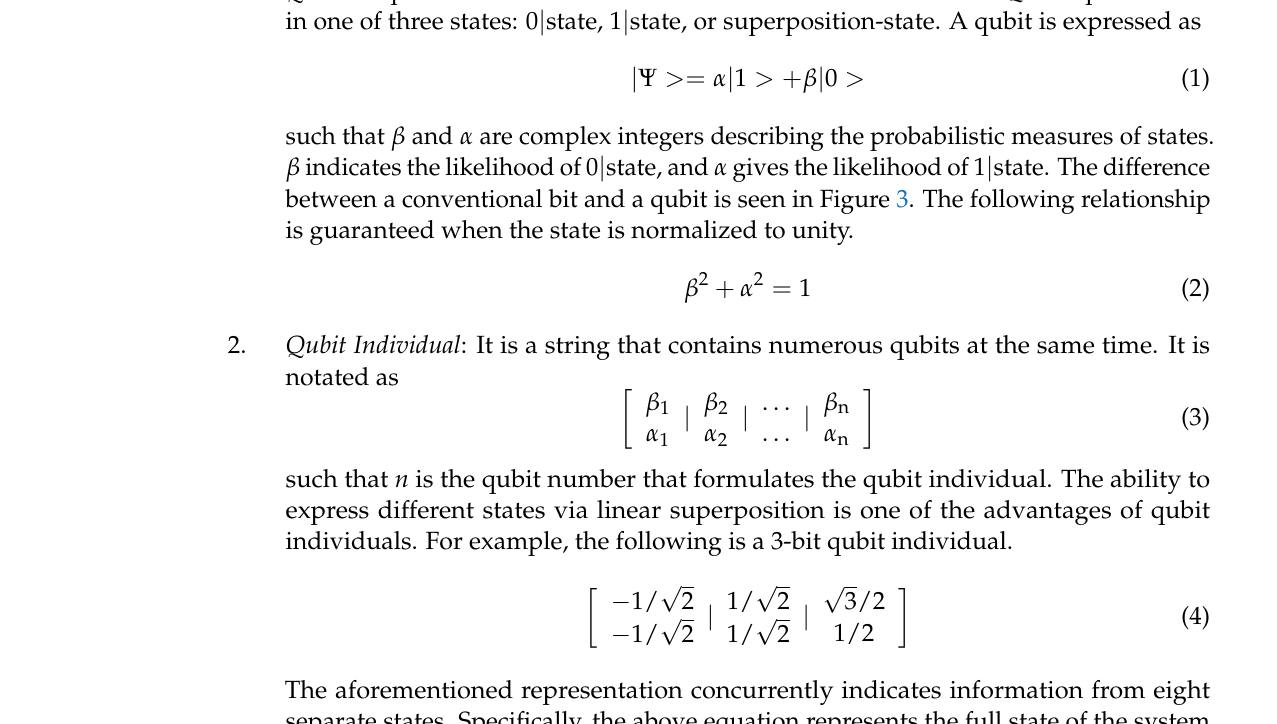
The aforementioned representation concurrently indicates information from eight separate states. Specifically, the above equation represents the full state of the system with appropriate probability as